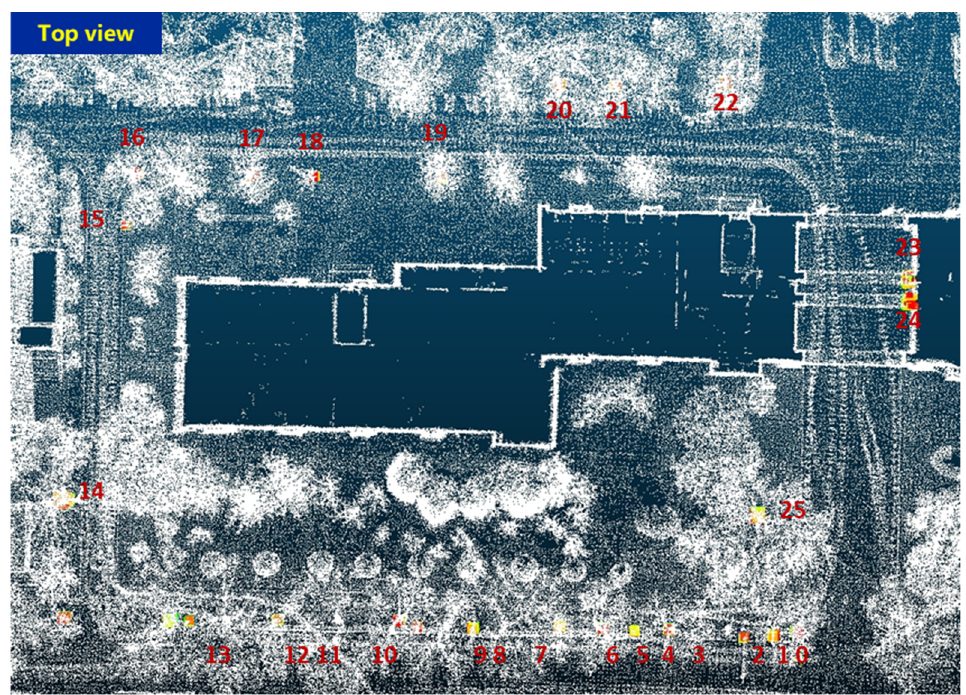
Figure 18. Detection targets in the map numbered 0–25, including tree trunks and lampposts.